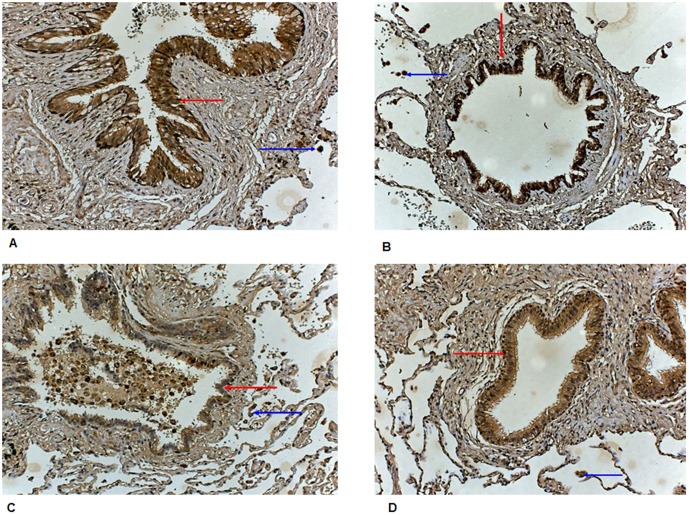
Immunohistochemistry of aldehyde dehydrogenase 3A1.Panel A: immunostaining of a COPD patient current smoker. Panel B: immunostaining of a healthy control current smoker. Panel C: immunostaining of a COPD patient ex-smoker. Panel D: immunostaining of a healthy control non-smoker. All COPD patients are GOLD STAGE II. The red arrows indicate epithelial cells and blue arrows indicate macrophages, more or less positive for ALDH3A1.